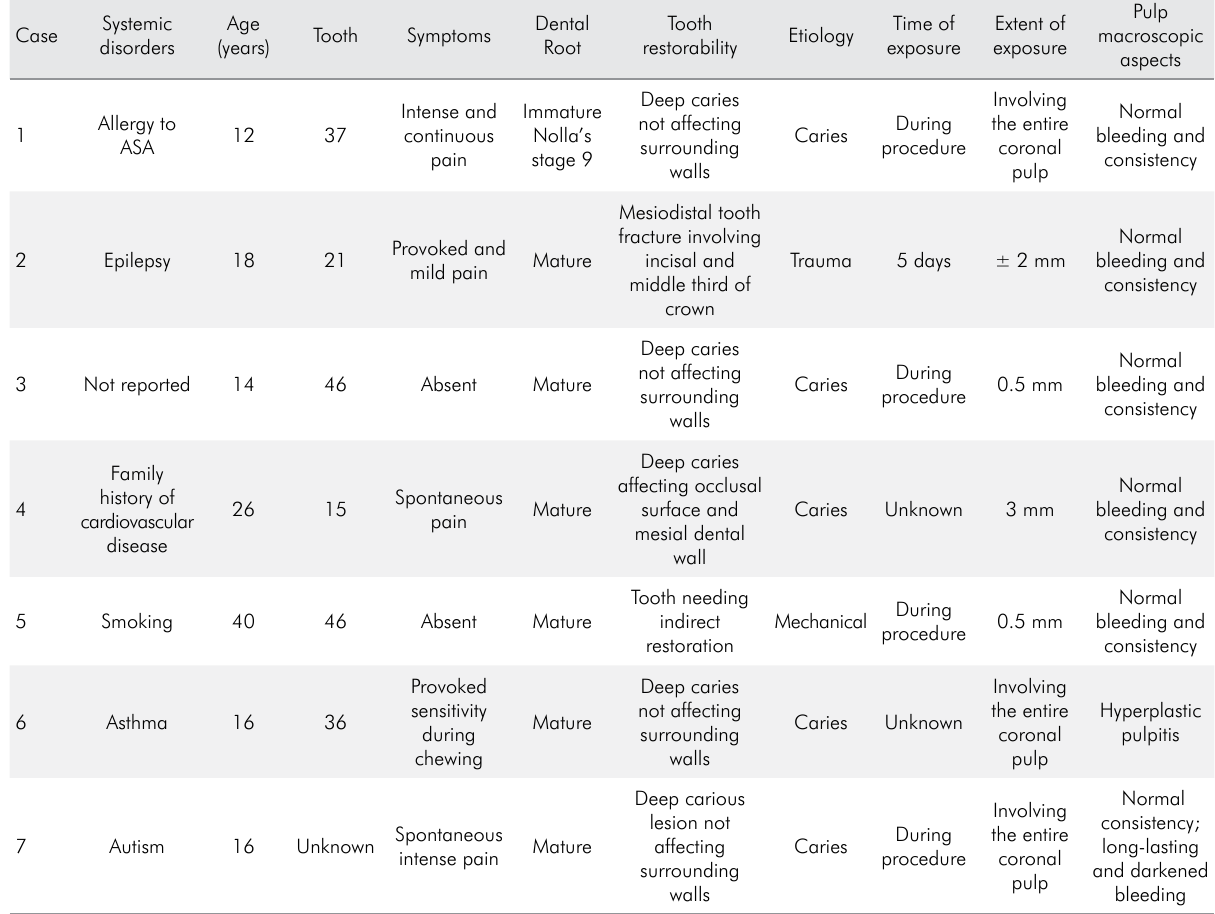
Table 1. Information provided in the simulated clinical case reports.